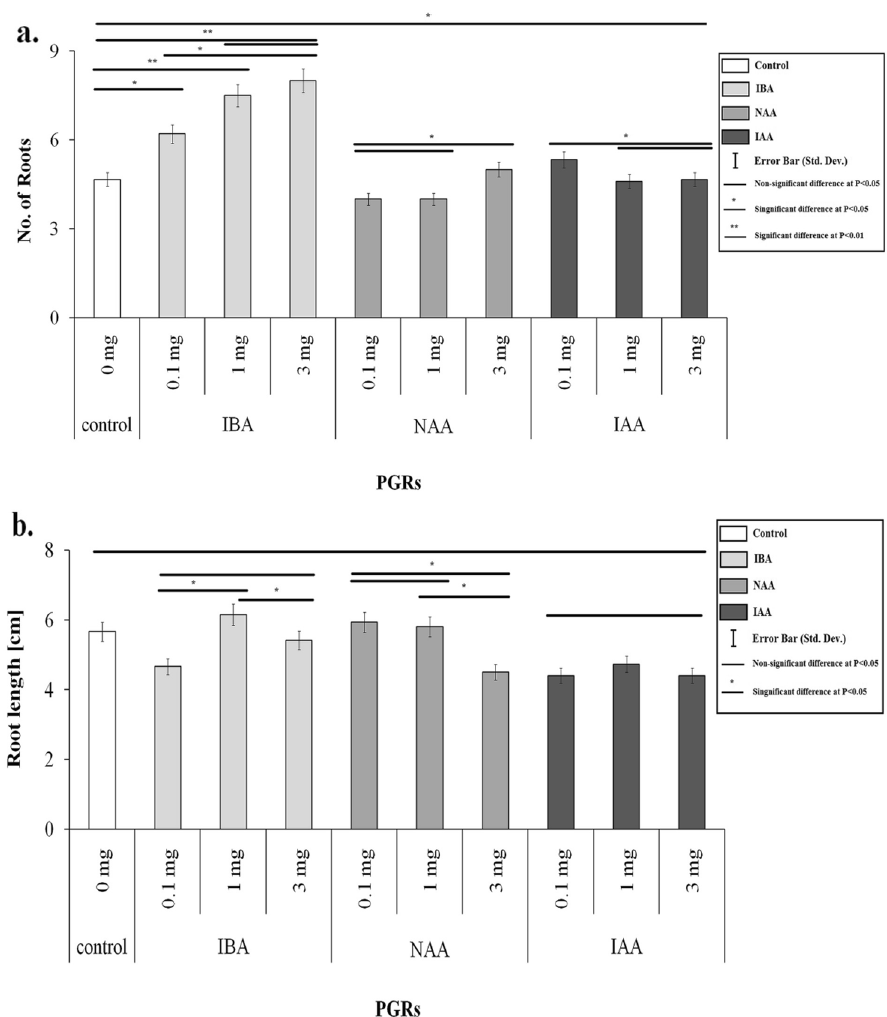
Figure 2. ( a ) Effect of PGRs on number of roots ( b ) Effect of PGRs on root